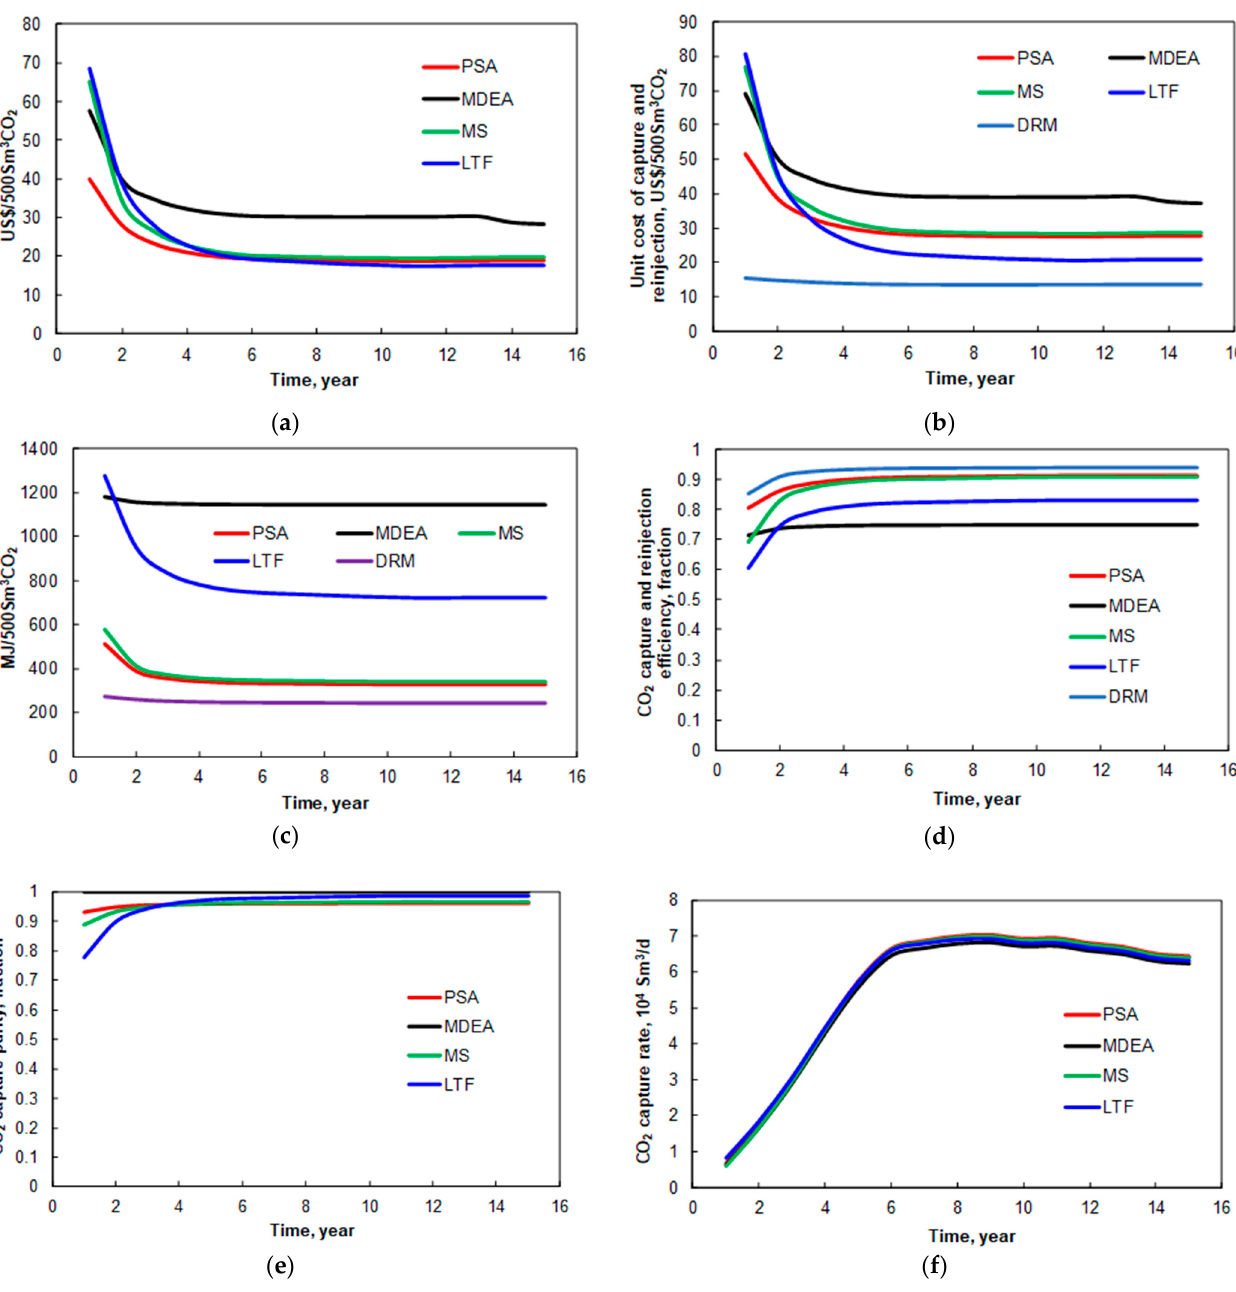
Figure 9. The calculated evaluation indicators of different CCRPs based on the predicted production of case D. ( a ) Unit cost of CO 2 capture; ( b ) Unit cost of CO 2 capture and reinjection; ( c ) Unit energy consumption; ( d ) CO 2 capture and reinjection efficiency (CCRE); ( e ) CO 2 capture purity; ( f ) CO 2 capture rate.